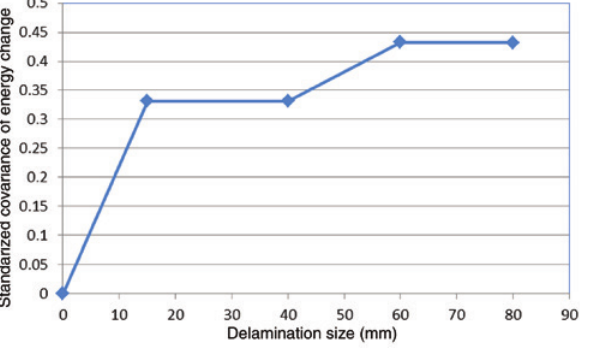
Figure 14: Covariance of energy change at Section 2.